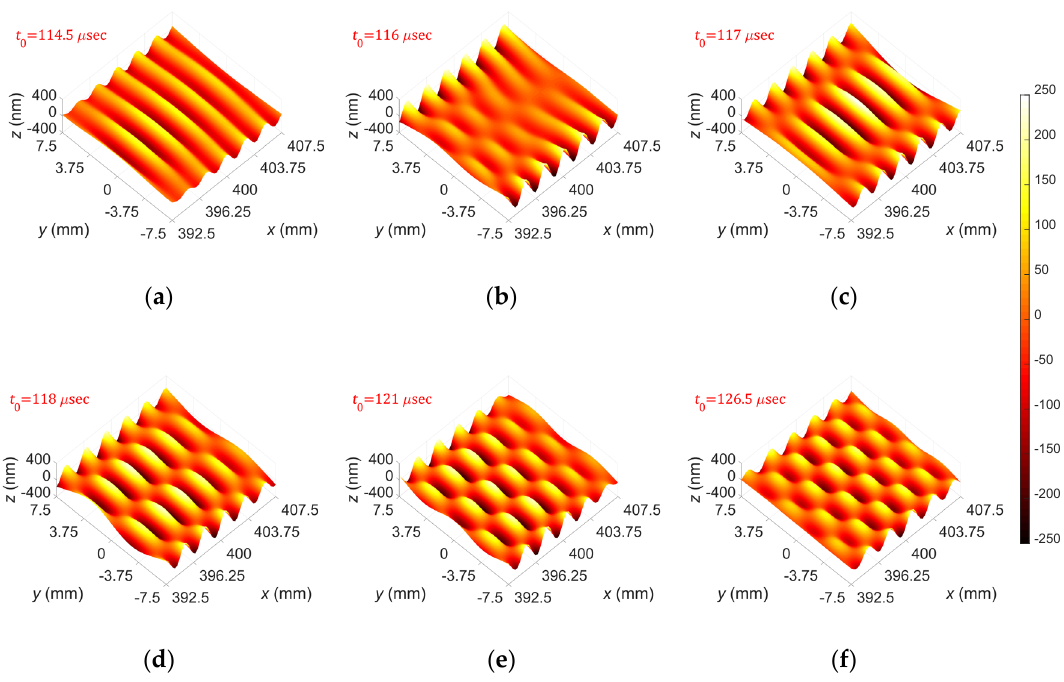
Figure 10. FEM simulation results of the conventional and the proposed wedges for excitation of the A(0,4) mode, ( a ) time history and ( b ) displacement distribution obtained by using the conventional wedge, ( c ) time history and ( d ) displacement distribution obtained by using the proposed wedge; time histories were picked up at side edge at 400 mm away from the excitation source.